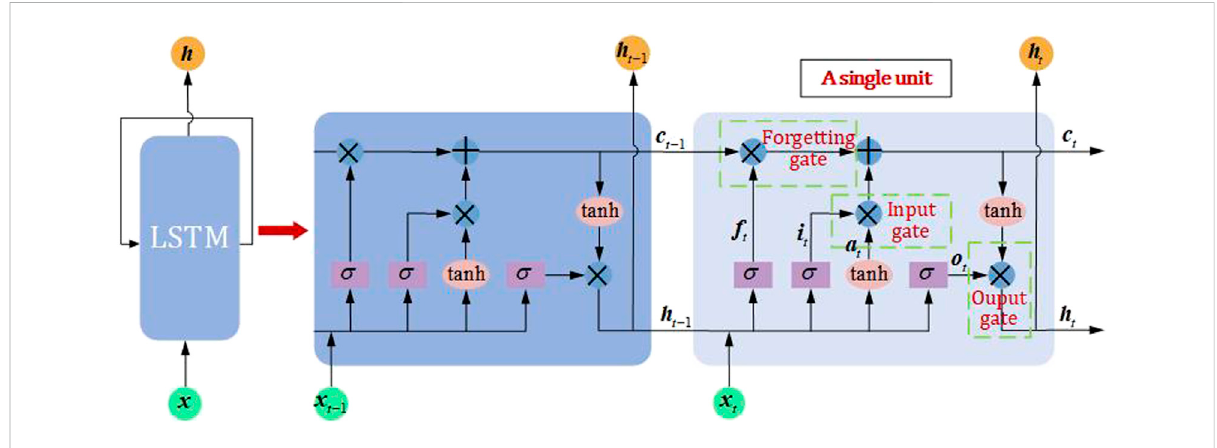
FIGURE 3 Structure of